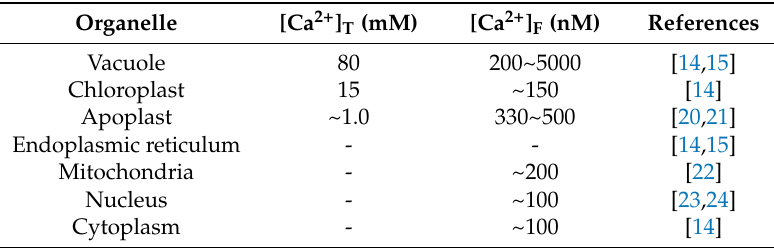
Table 1. The concentration of Ca 2+ in plant